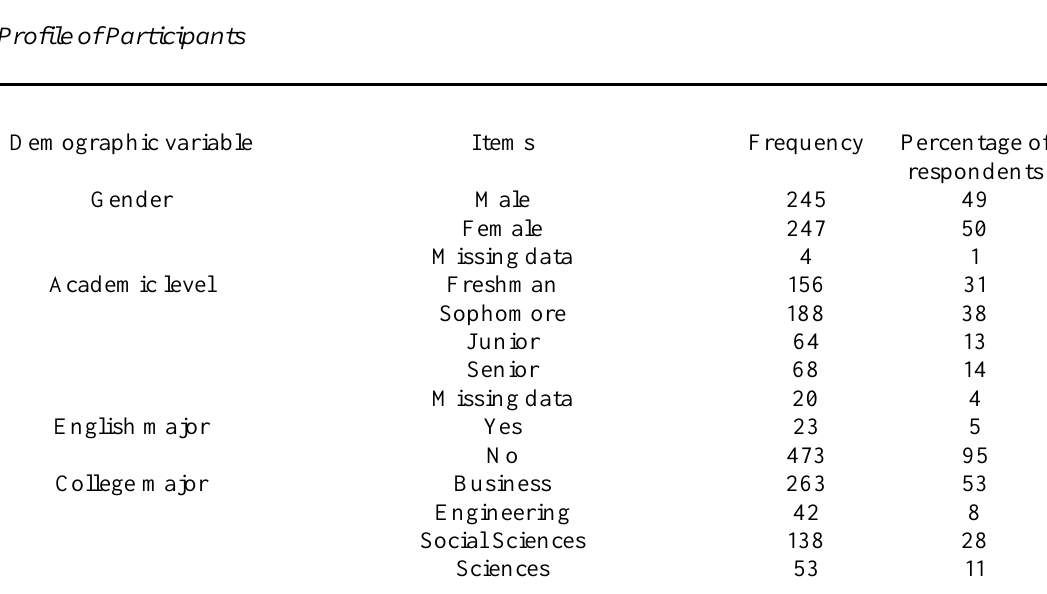
Profile of Participants